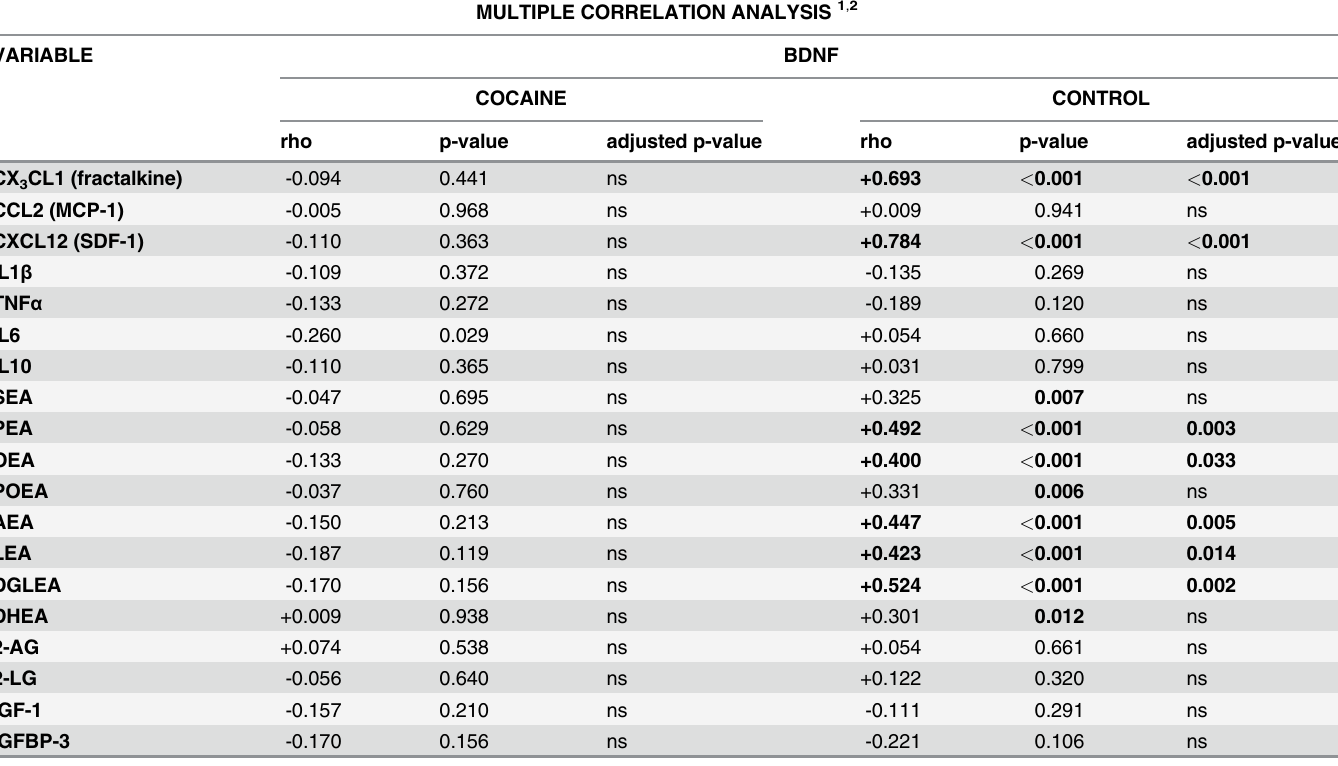
Table 2. Multiple correlations between plasma concentrations of BDNF and other plasma molecules in the cocaine group. MULTIPLE CORRELATION ANALYSIS 1 ,